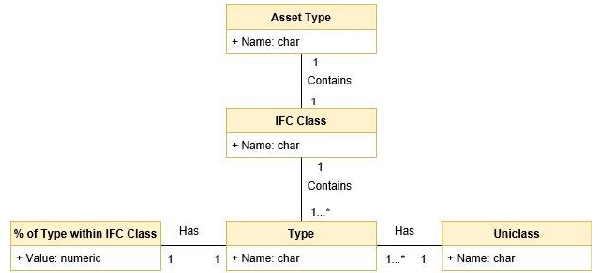
Figure 5: UML Representation Structure of Phase 3